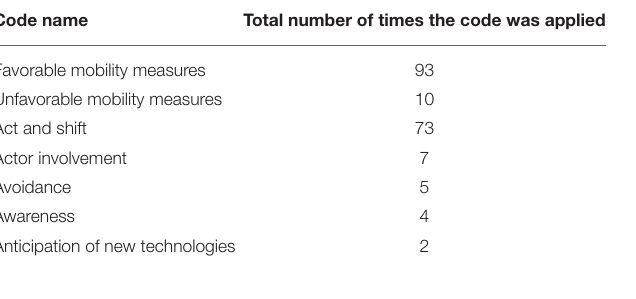
TABLE 2 | COVID-19 mobility measures in terms of favoring sustainable mobility, and in terms of the 5A’s.